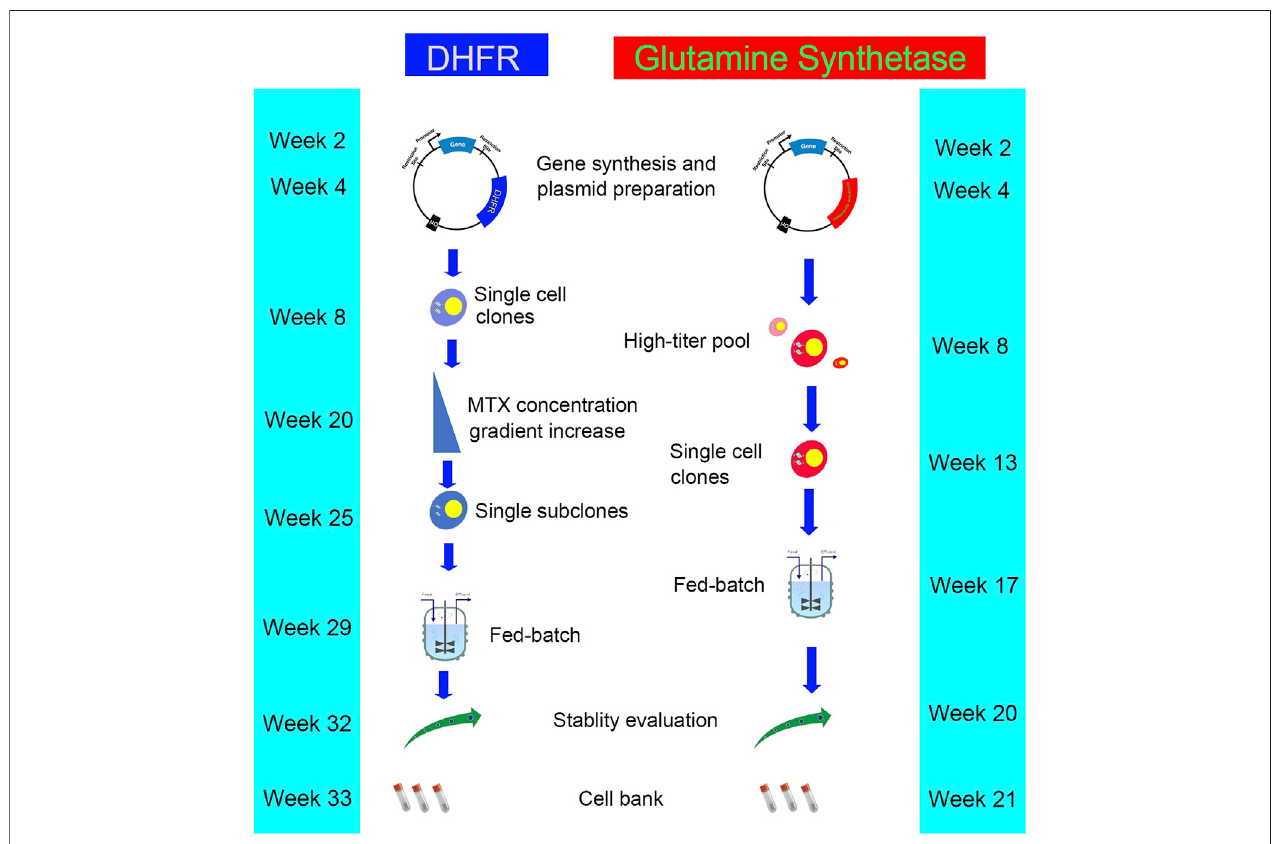
FIGURE 2 | The work fl ow and timeline for DHFR and GS